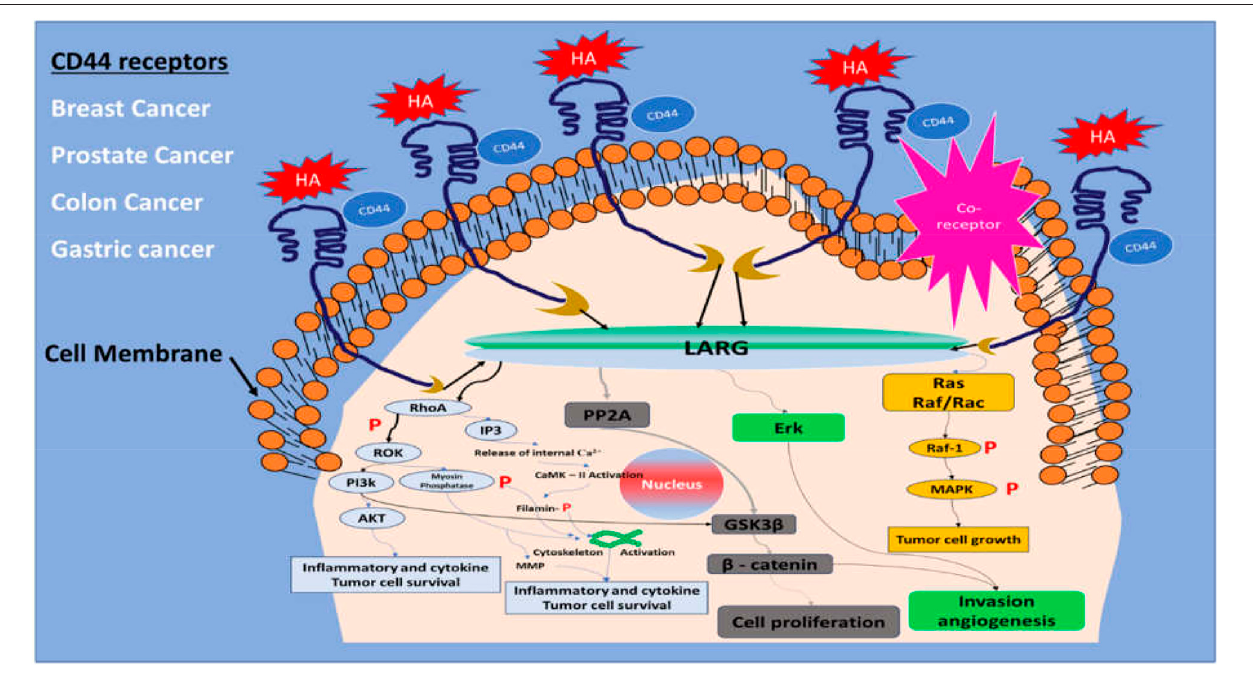
FIGURE 3 | Cell signaling pathways associated with the CD44